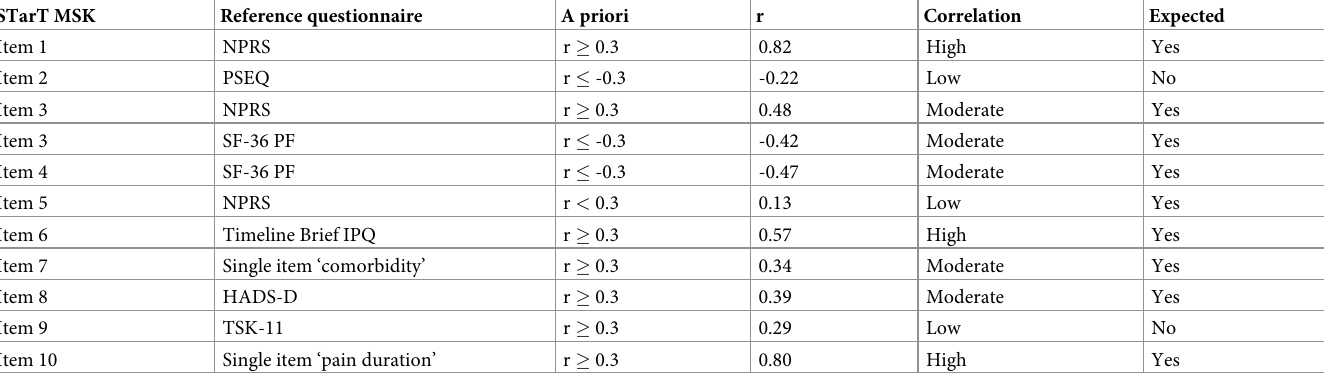
Table 2. Pearson’s correlation between the Dutch STarT MSK tool and reference questionnaires.